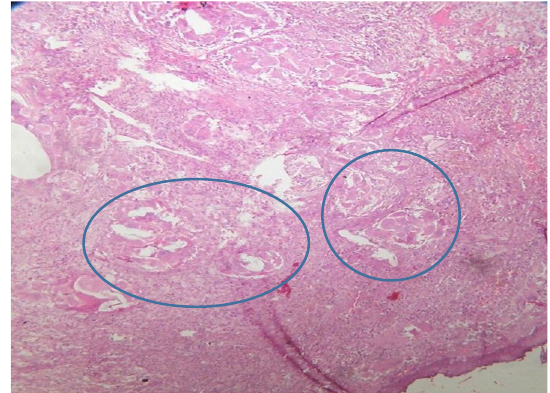
Fig. 3 Granulomatous inflammation (blue circles) composed mainly of foreign body type giant cells and chronic inflammatory cells infiltrate that surrounding hair shafts (H&E stain;